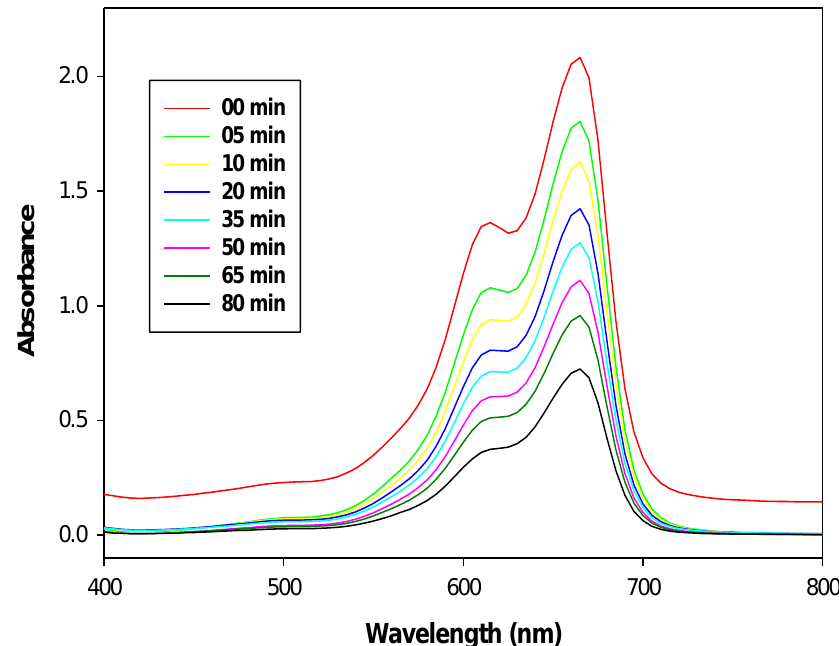
Figure 7. An absorption spectrum for methylene blue decolorization in the presence of zinc oxide.